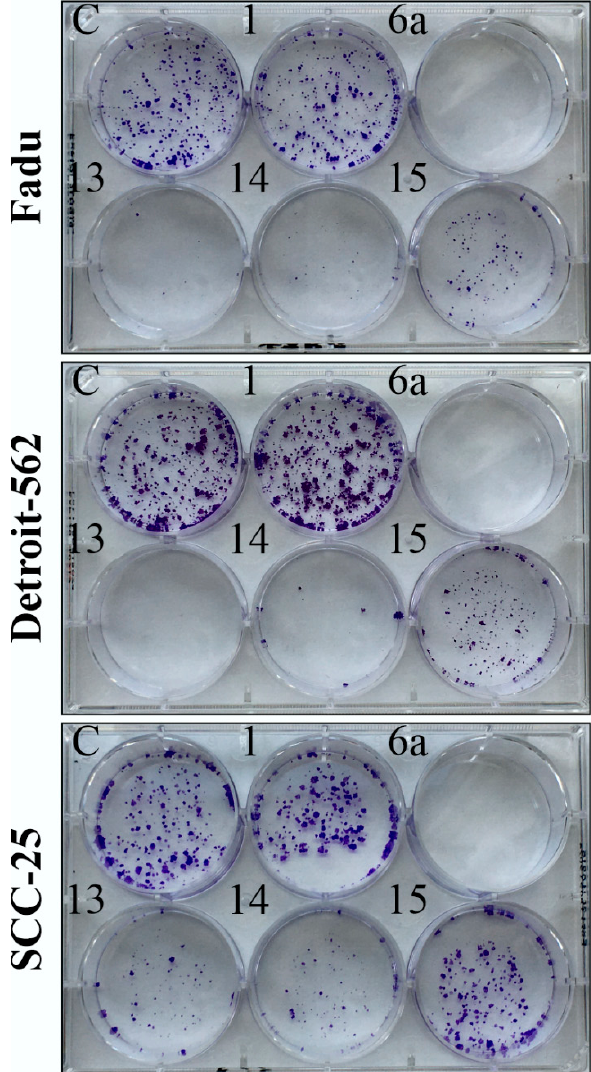
Figure 5. Colony formation assay of HNSCC cells using 2.5 uM concentration, 24 h treatment time and 1-week-long postincubation in treatment-free cell culture medium. C : control (medium containing 0.2% DMSO); 1 : erlotinib; 6a , 13 and 14 : hybrids; 15 : chalcone.